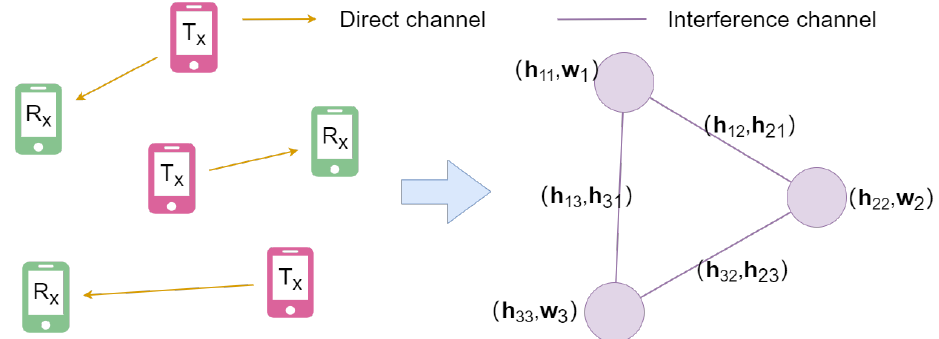
Figure 1. Constructing graph for Ad Hoc network with 3 transceivers.